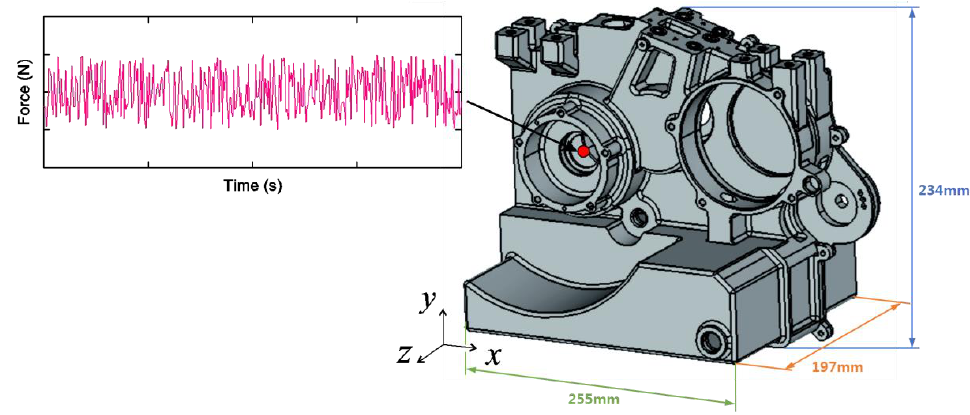
Figure 1. Example of gearbox housing under gear-induced dynamic loading at a bearing center.